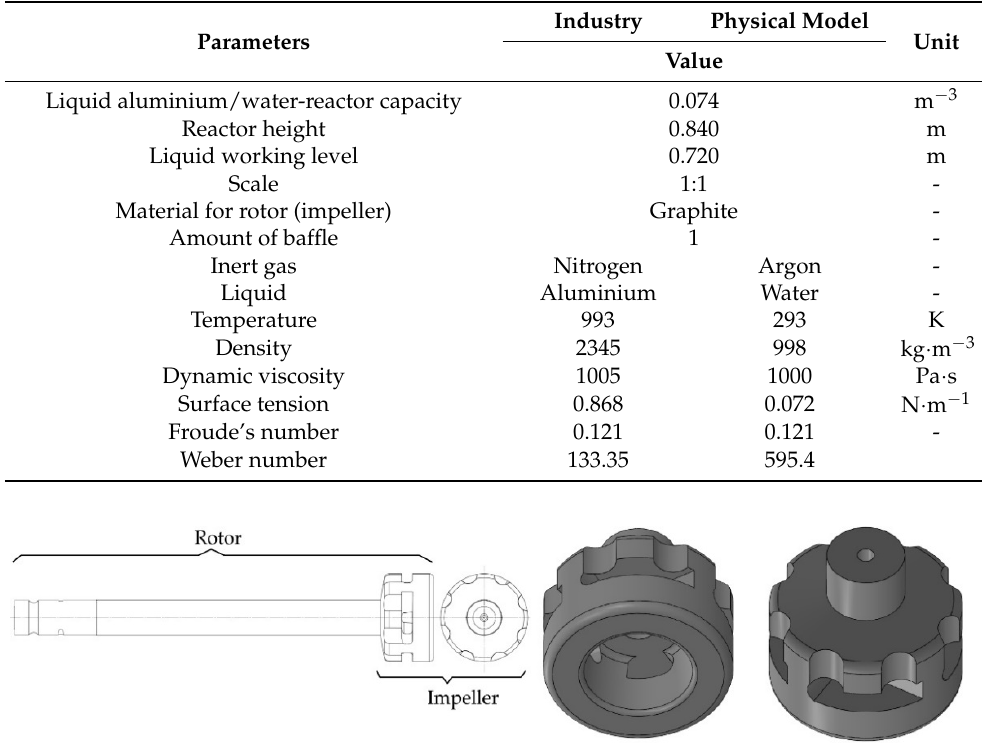
Figure 3. A 3D view of the rotor (impeller).